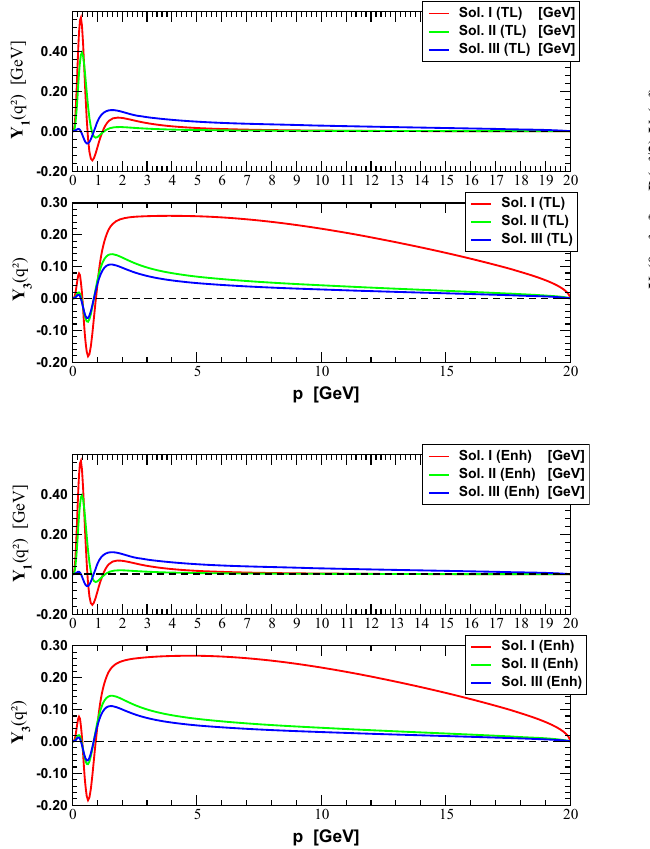
Fig. 16 The quark-ghost kernel form factors X 1 and X 3 computed for the tree level ghost-gluon vertex (top) and the enhanced gluon-ghost vertex (bottom)